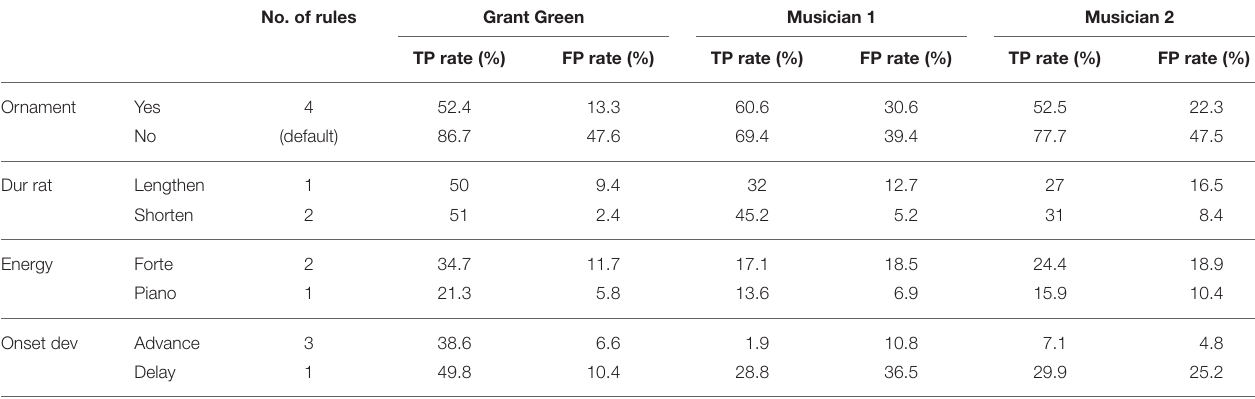
TABLE 9 | Model performance measured as true/false positives on train data (Grant Green) and test data (Musicians 1 and